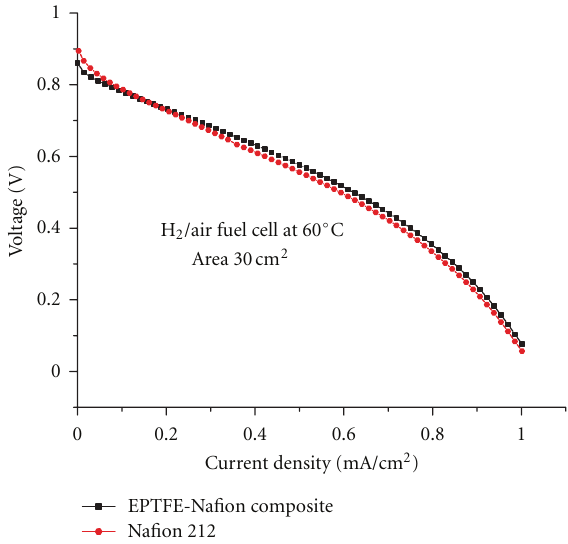
Figure 5: Comparison in performance between composite mem- brane and Nafion 112 at 60 ◦ C and ambient pressure